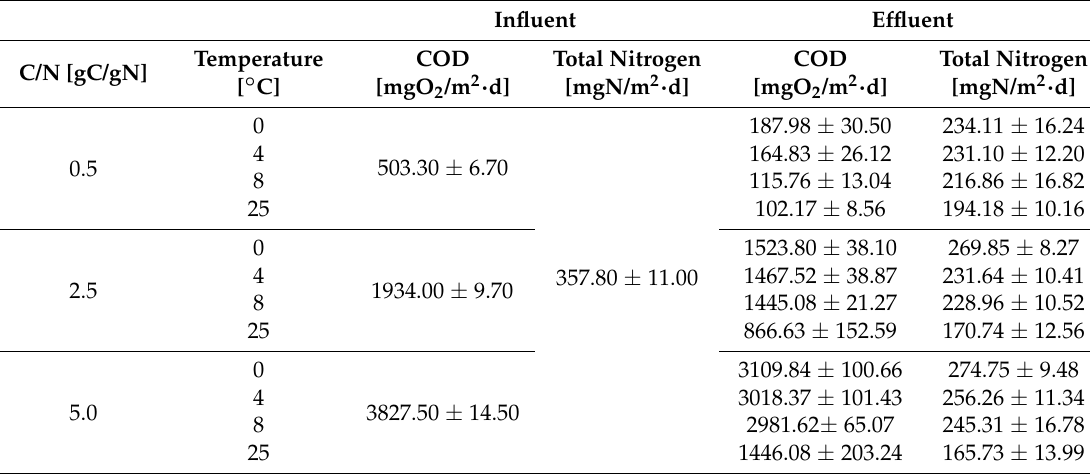
Table 4. Mass balance of the overall wastewater treatment